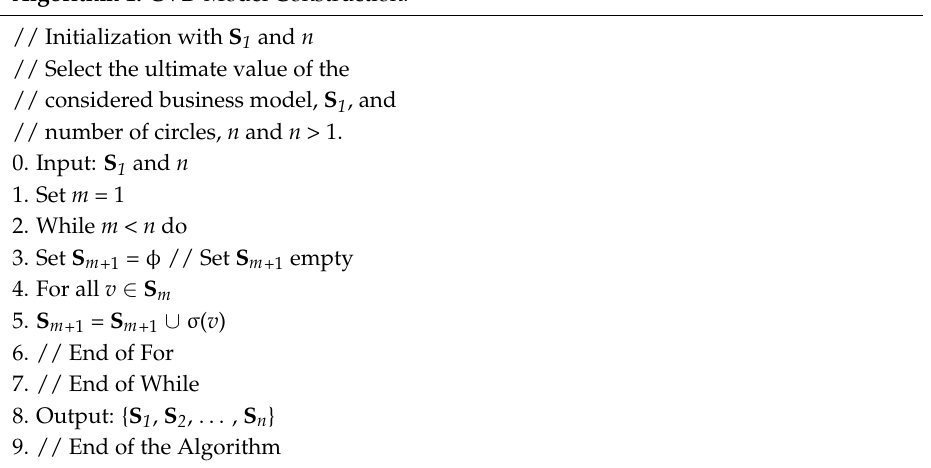
Algorithm 1. CVD Model